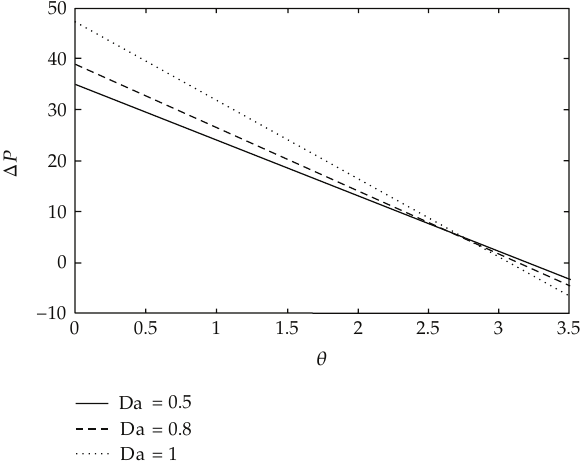
Figure 2: The pressure rise verses flow rate when α (cid:9) 0 . 01 , a (cid:9) 0 . 2, b (cid:9) 0 . 6 , d (cid:9) 0 . 8 , ε (cid:9) 0 . 3 , λ 1 (cid:9) 0 . 4, and φ (cid:9) π/